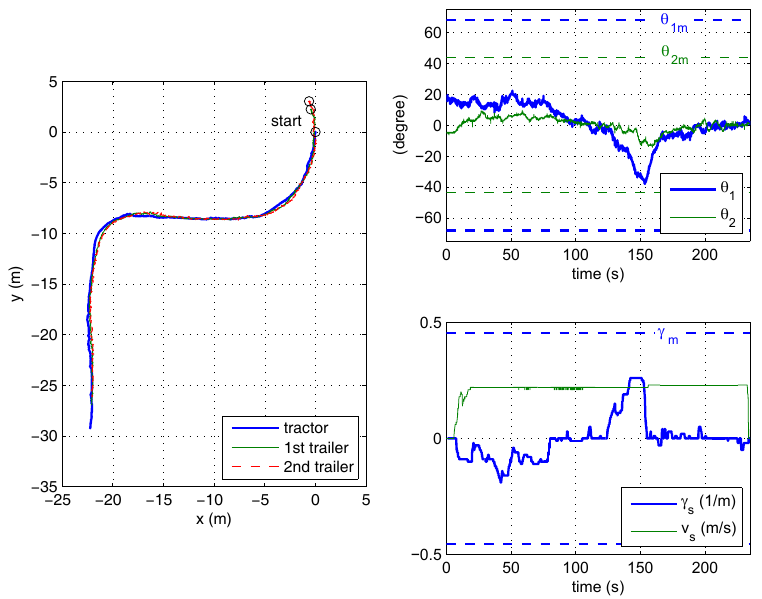
Figure 9. Forward driving with the off/on axle setup: paths of the tractor and trailers ( left ); hitch angles with corresponding mechanical limits ( top right ); driver commands and curvature limitations ( bottom right